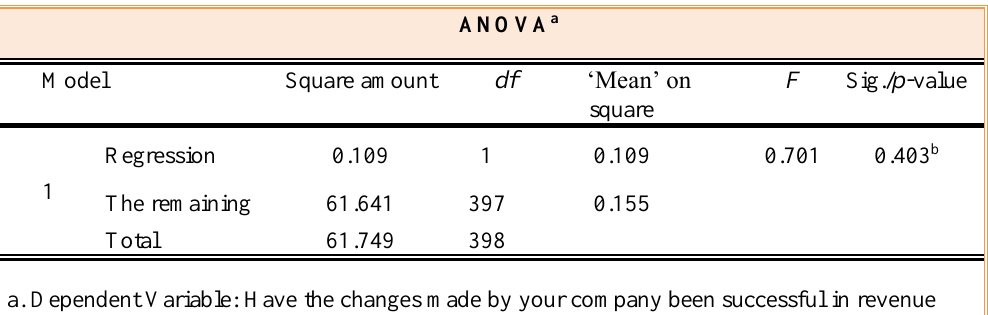
Table 2. Methods Used by the Company to Handle Resistance to Change (developed by the author)